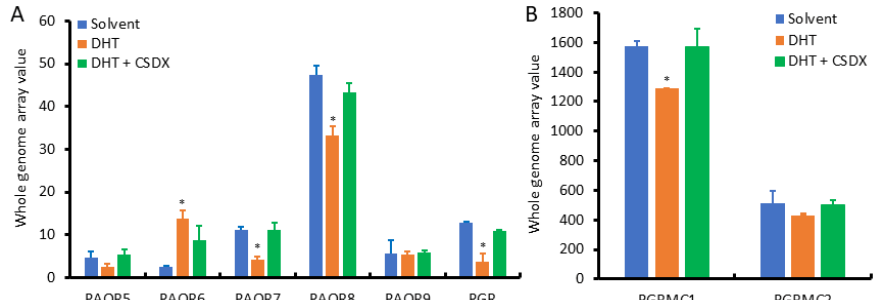
Figure 6. ( A , B ) Androgen modulates PAQR gene expression in prostate cancer cells. Prostate cancer LNCaP cells were treated with DHT (1.0 nM) for 16 h with or without Bicalutamide retreatment. Total RNAs were extracted for cDNA microarray with the Affymetrix Human Genome U133 Plus